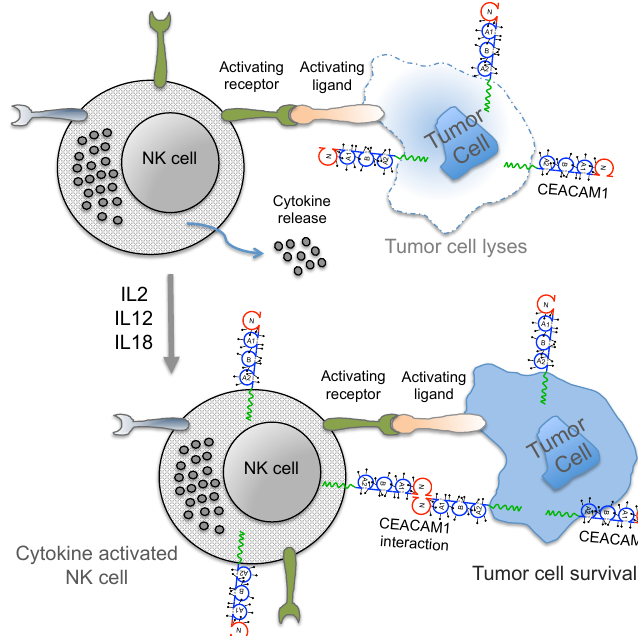
Figure 2. Summary of the natural killer (NK) activation mechanisms modulated by CEACAM1. (top) The interaction of activating receptors on NK cells with activating ligands present on malignant cells facilitates the cytotoxic activity of NK cells and, consequently, the tumor cell lyses. (down) CEACAM1 expression induced in cytokine activated NK cells interacts with tumor cell associated CEACAM1, thus inhibiting the cytolytic function of NK